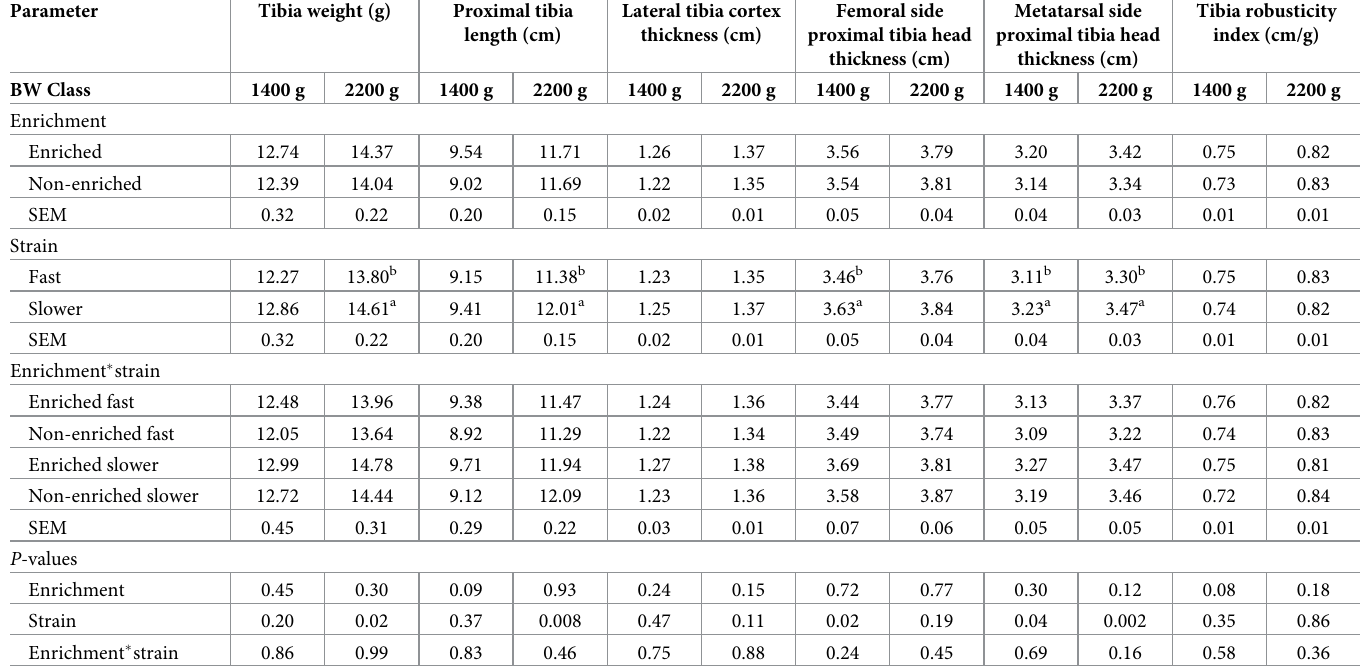
Table 3. Effects of pen enrichment (enriched or non-enriched), broiler strain (fast-growing ross 308 or slower-growing Hubbard JA 757) and their interaction on tibia morphological characteristics of male broiler chickens in two body weight classes (1400 and 2200 g) (2 chickens per pen, n = 7 pens per treatment, LSmeans ±